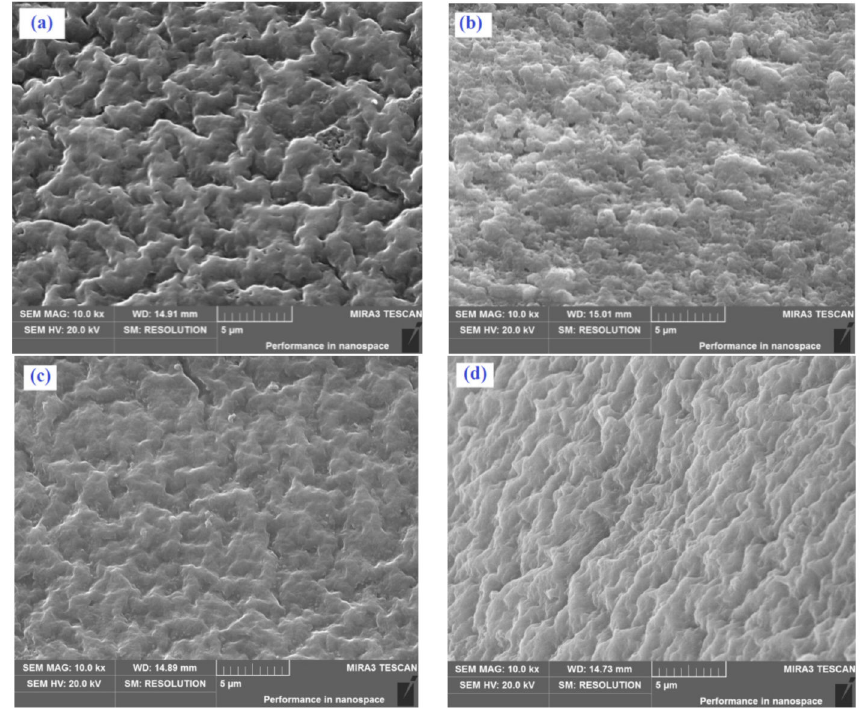
Figure 2. Scanning electron microscope (SEM) photographs of PAMHA ( a ) before, and after ( b ) La(III), ( c ) Ce(III), or ( d ) Y(III) adsorption.